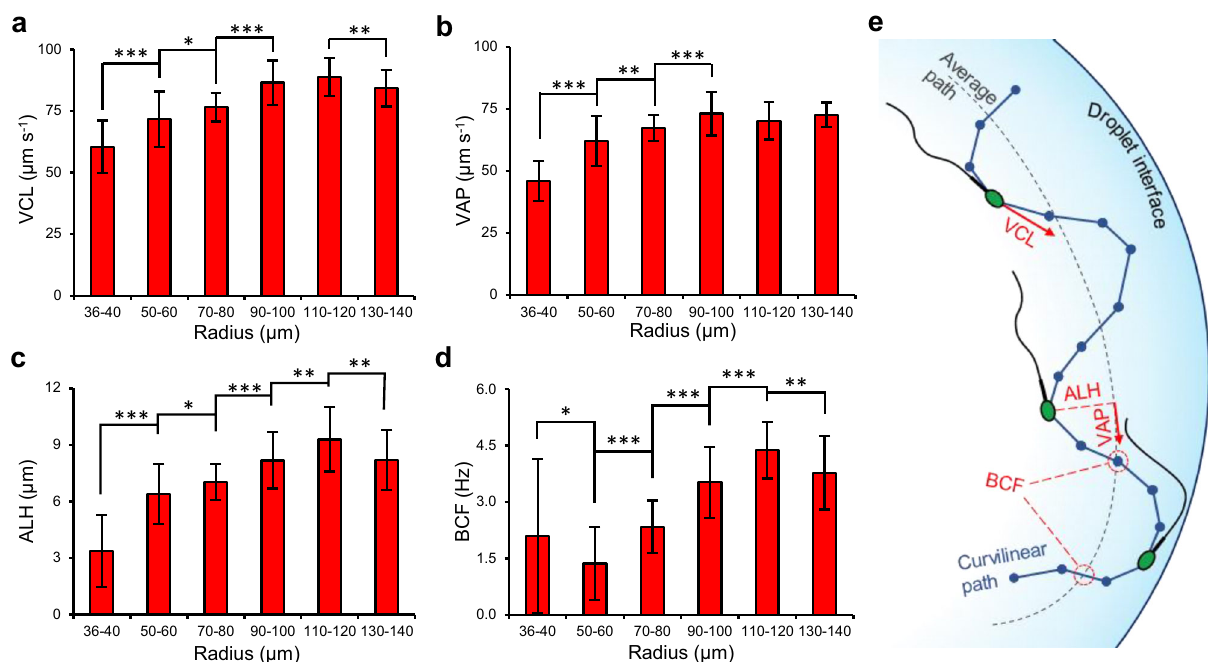
Fig. 4 Sperm motility parameters at curved interfaces. a Curvilinear velocity (VCL), ( b ) average path velocity (VAP), ( c ) amplitude of lateral head displacement (ALH), and ( d ) beat cross frequency (BCF) for sperm swimming in droplets ranging in radius from 36 µ m to 140 µ m. Values are reported as mean±s.d. ( n = 45, 46, 45, 46, 45, and 45 biologically independent cells examined over 5, 4, 4, 4, 5, and 4 independent experiments for sperm swimming in * P ≤ 0.05, ** P ≤ 0.01, *** P ≤ 0.001 (for exact P values see Supplementary Table 3), and for data distribution see Supplementary Fig. 11. e Schematic representation of the measured sperm motility parameters. Source data are provided as a Source Data fi